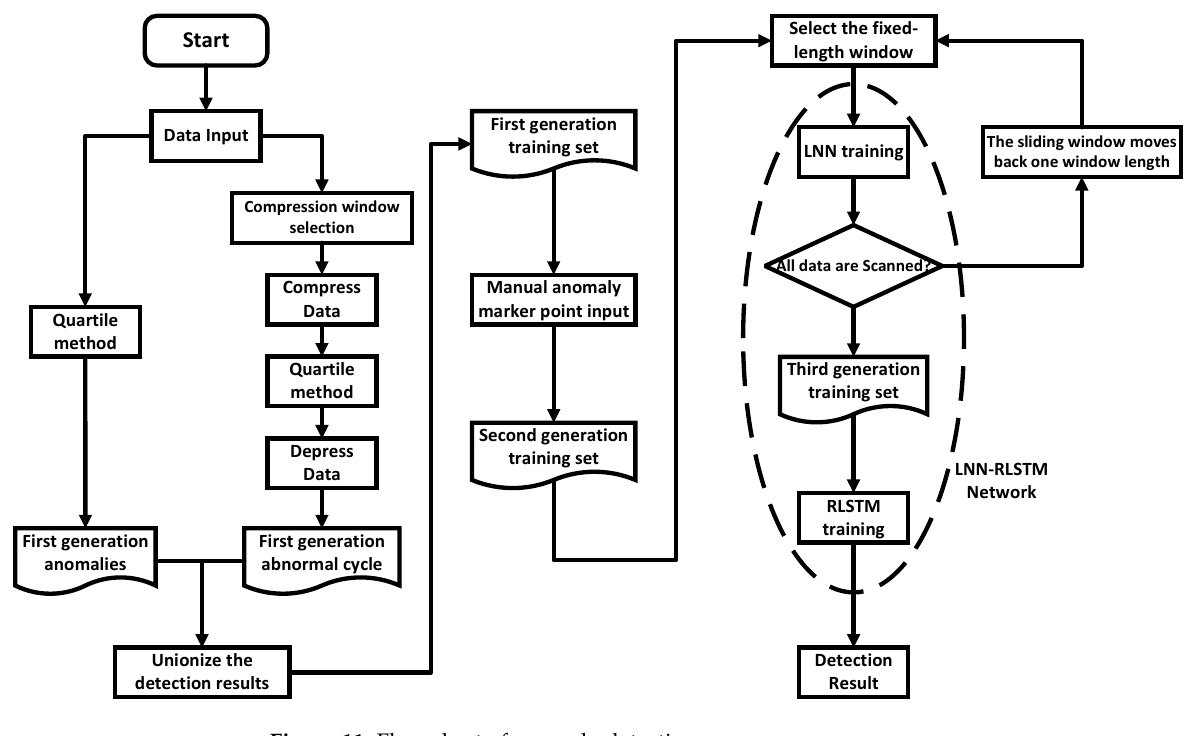
Figure 11. Flow chart of anomaly detection.